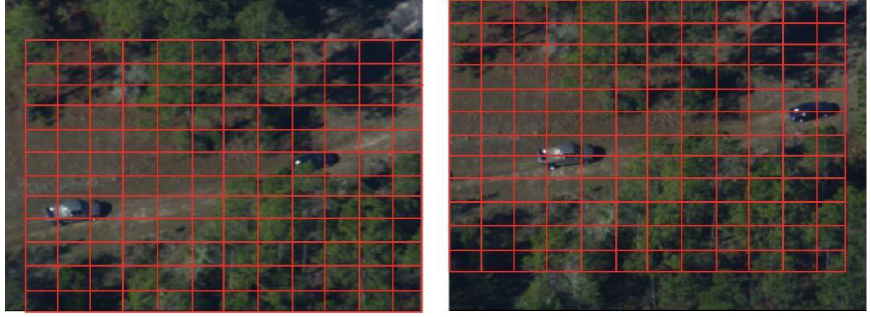
Figure 4. Meshing